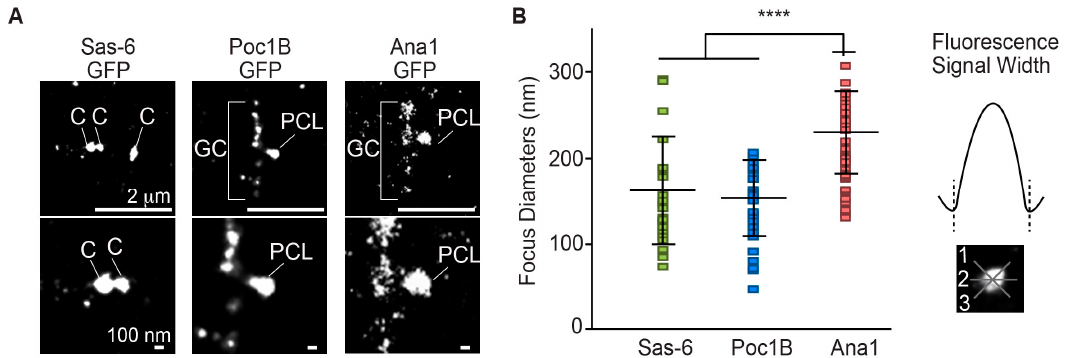
Figure 3. Poc1B and Sas-6 localize in the PCL core. ( A ) Maximum intensity projection of direct stochastic optical reconstruction microscopy (dSTORM) super-resolution micrographs of sperm centrioles containing gSas-6-GFP, gPoc1B-GFP, and Ana1-GFP. Sas-6 diameters were obtained from the spermatocyte centrioles. Poc1B and Ana1 were obtained from elongating spermatids PCL. ( B ) The diameter quantification of dSTORM micrographs of gSas-6-GFP (N = 26), gPoc1B-GFP (N = 38), and Ana1-GFP (N = 43). Sas-6 and Poc1B had similar diameters that were significantly smaller than Ana1. Each measurement was measured 3 times as depicted on the right. **** p < 0.0001. 3.5. Ana2 and Sas-6 Overexpression Can Induce PCL-Like Structure That Contains Poc1.